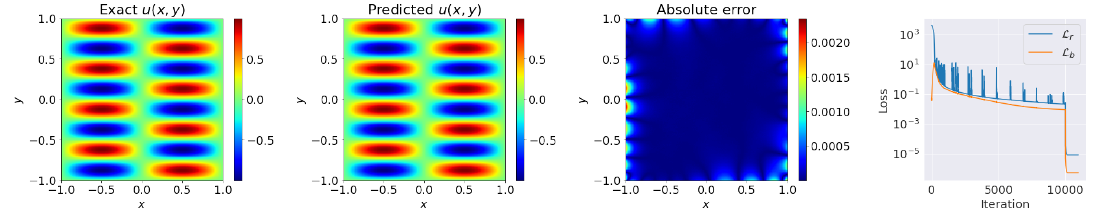
Figure 6. cSPINNs results (with ResNet block-enhanced modified neural network) for solving the 2D Helmholtz equation with an exact